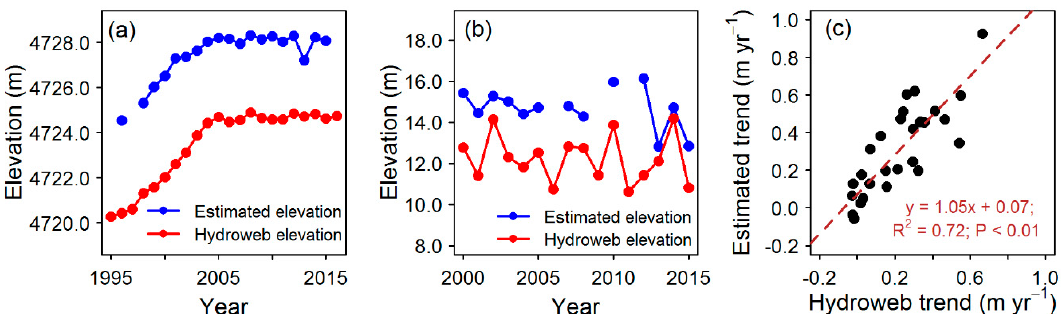
Figure 6. Accuracy assessment of elevation estimation. ( a ) Comparison of the temporal trends between estimated elevation and Hydroweb water level for Nam Co lake, 1995–2015. ( b ) Comparison of the temporal trends between estimated elevation and Hydroweb water level for Poyang lake, 1995–2015. ( c ) Comparison of the changing rate of our estimated elevation with the trend from Hydroweb water level data (N = 30). The brown dashed line represents the linear regression line.